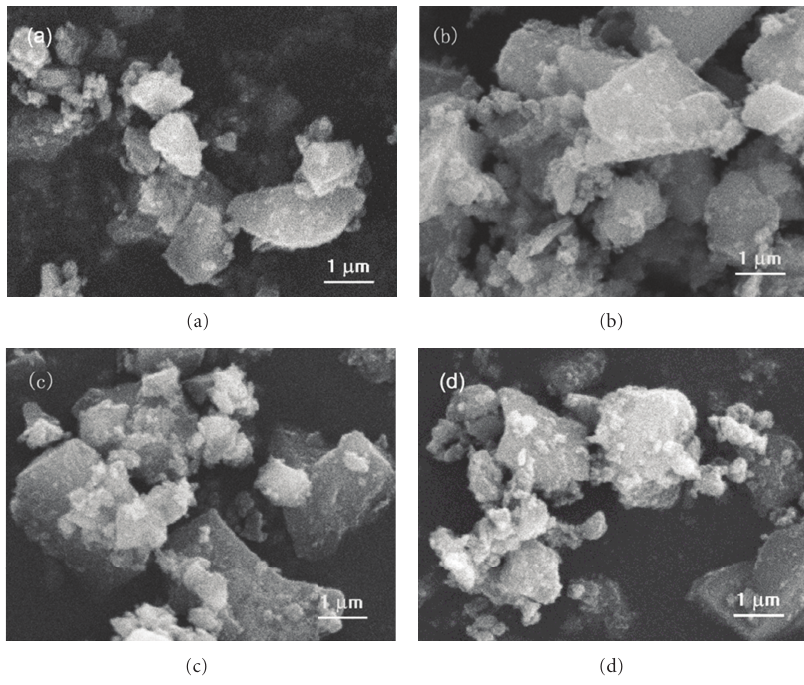
Figure 2: SEM images of 3% B-TiO 2 samples calcinated at (a) 300 ◦ C, (b) 400 ◦ C, (c) 500 ◦ C, and (d) 600 ◦ C, respectively.